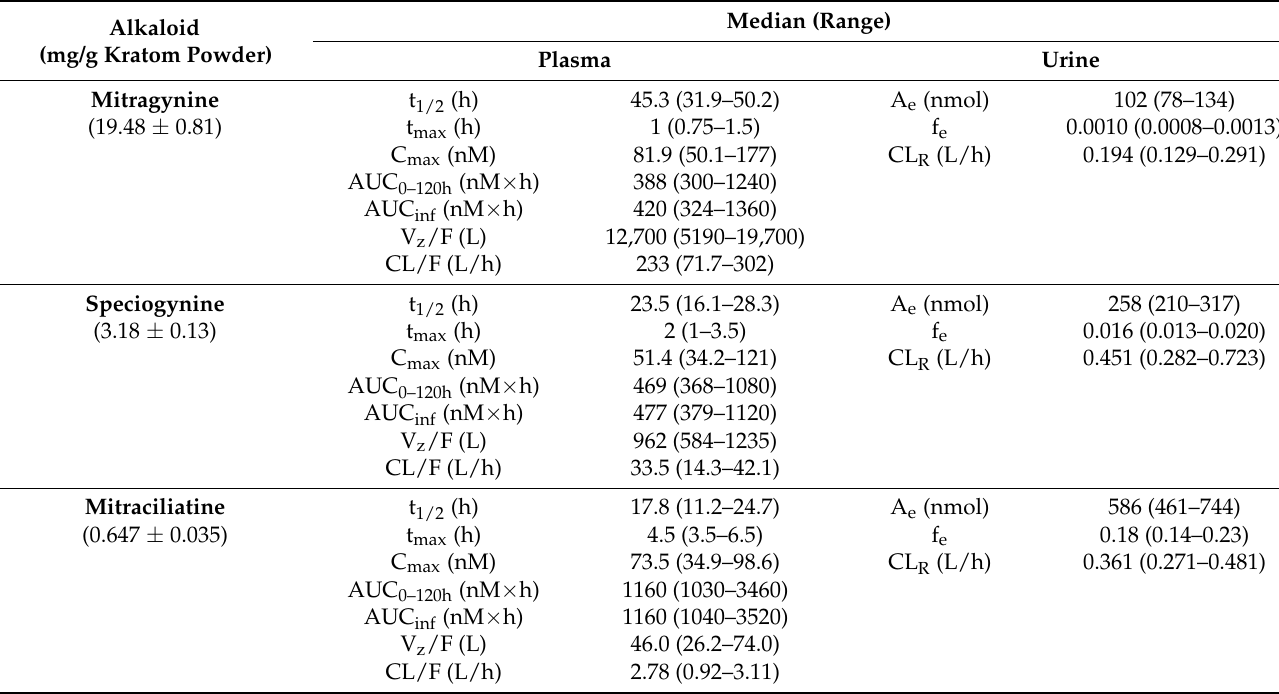
Table 1. Noncompartmental-analysis-derived pharmacokinetics of kratom alkaloids in healthy adult participants ( n = 5 who completed the study) administered a well-characterized kratom product (2 g) as a